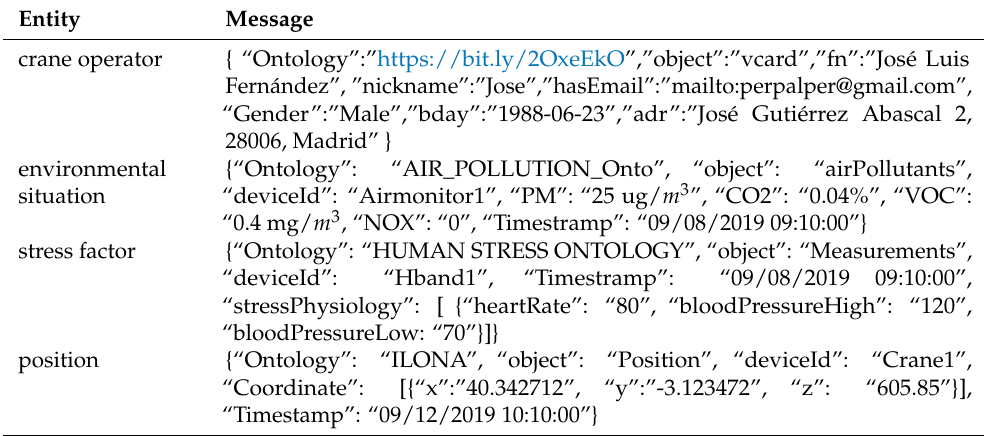
Table 1. Data streams with semantic